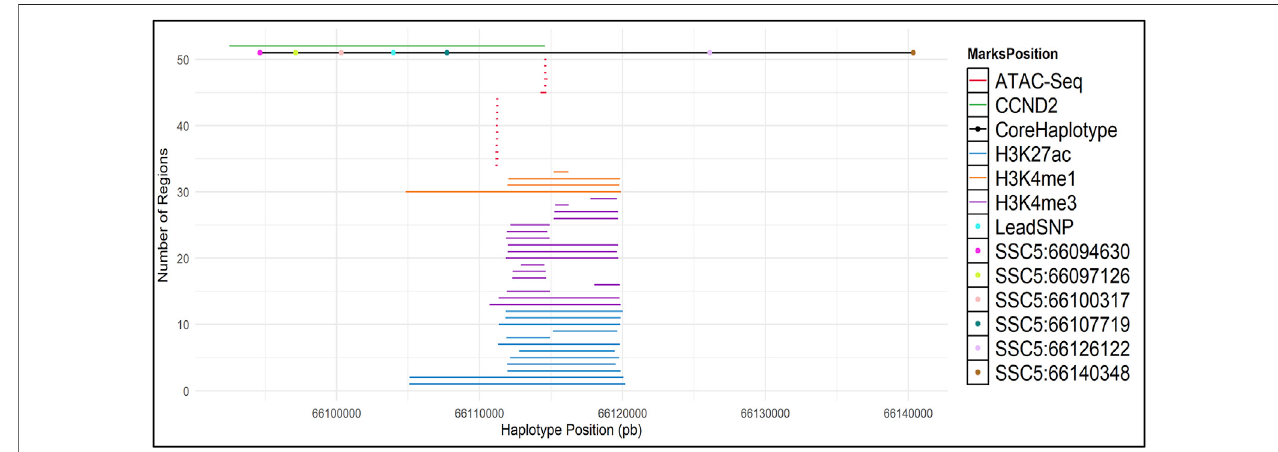
FIGURE 4 | ATAC-Seq and ChIP-Seq (H3K27ac, H3K4me1 and H3K4me3) marks in the CCND2 backfat locus. Broad Peaks in the core haplotype region were called using